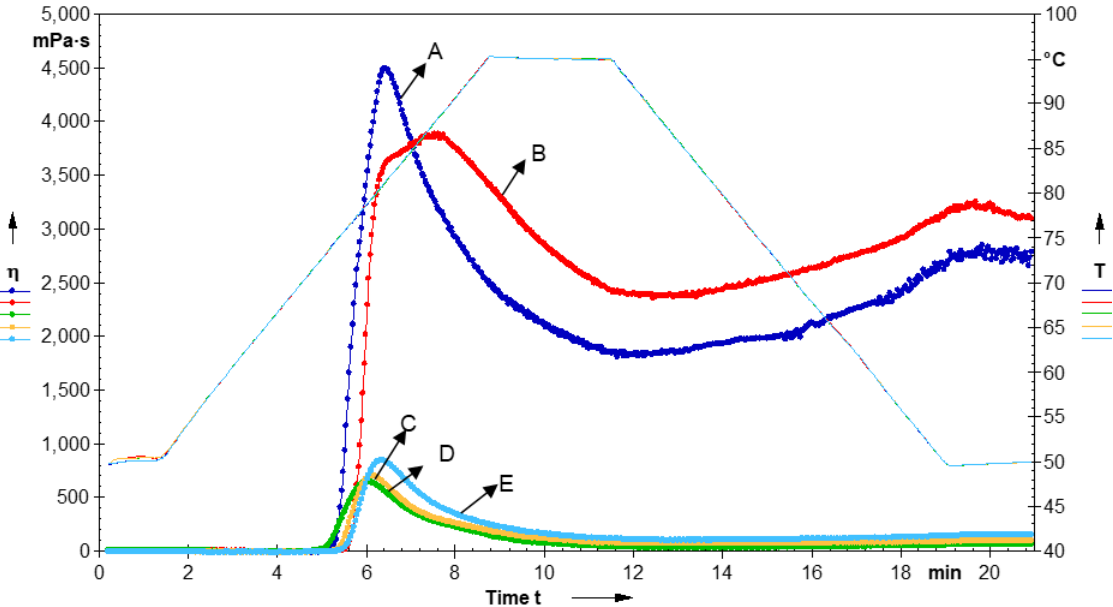
Figure 5. Pasting profile of native and modified lotus rhizome starches. A — Native; B — MI; C — IR; D — MI-IR; E — IR-MI.